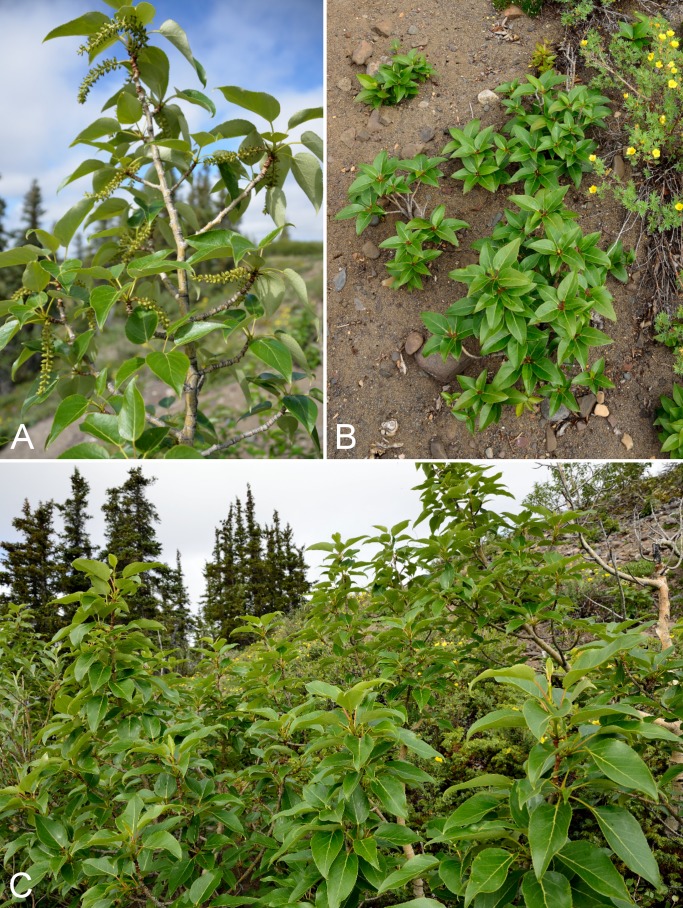
Populus balsamifera.(A) Catkins, Saarela et al. 3457. (B) Habit, Saarela et al. 3457. (C) Habitat, Saarela et al. 3457. Photographs by R. D. Bull.